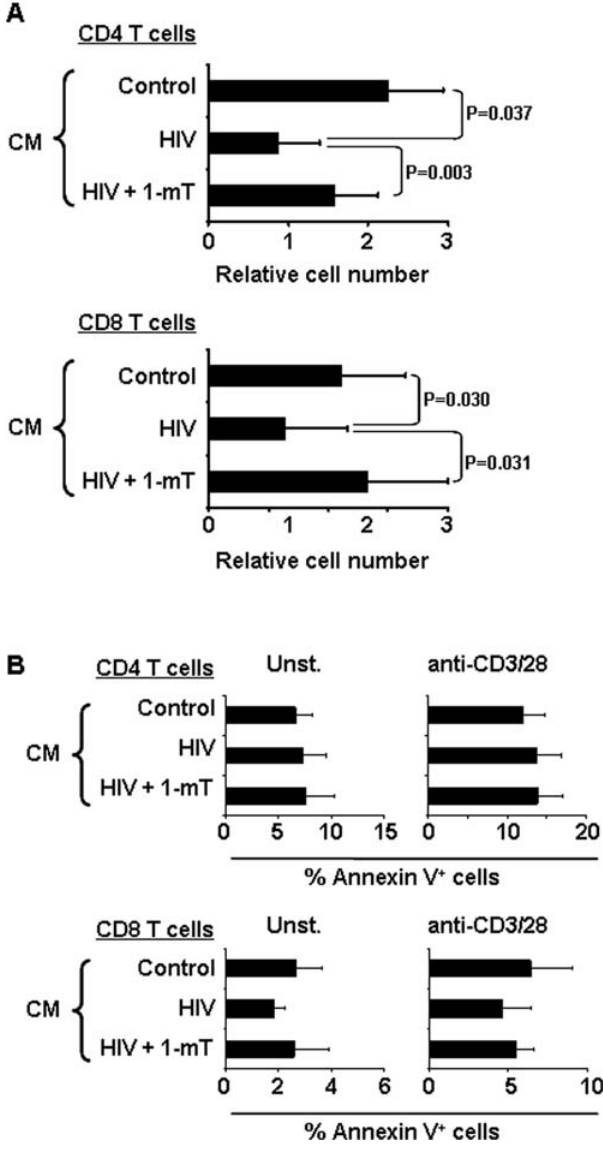
Figure 4. HIV-induced IDO suppresses both CD4 and CD8 T cell proliferation in a 2-step experiment. ( A ) CD4 and CD8 T cell proliferation is shown as the increase in the number of viable cells measured using a bioreduction assay. Relative cell number was calculated for each sample as ratio between stimulated (with anti- CD3 and anti-CD28) and unstimulated cells cultured in the three different conditioned media (CM). ( B ) CD4 and CD8 T cell apoptosis is shown as frequency of annexin V + cells measured by flow cytometry. Apoptosis of cells cultured in the three different conditioned media (CM) is shown for both unstimulated and stimulated (with anti-CD3 and anti-CD28) cells. In all cases mean values 6 standard error calculated on 8 independent experiments are